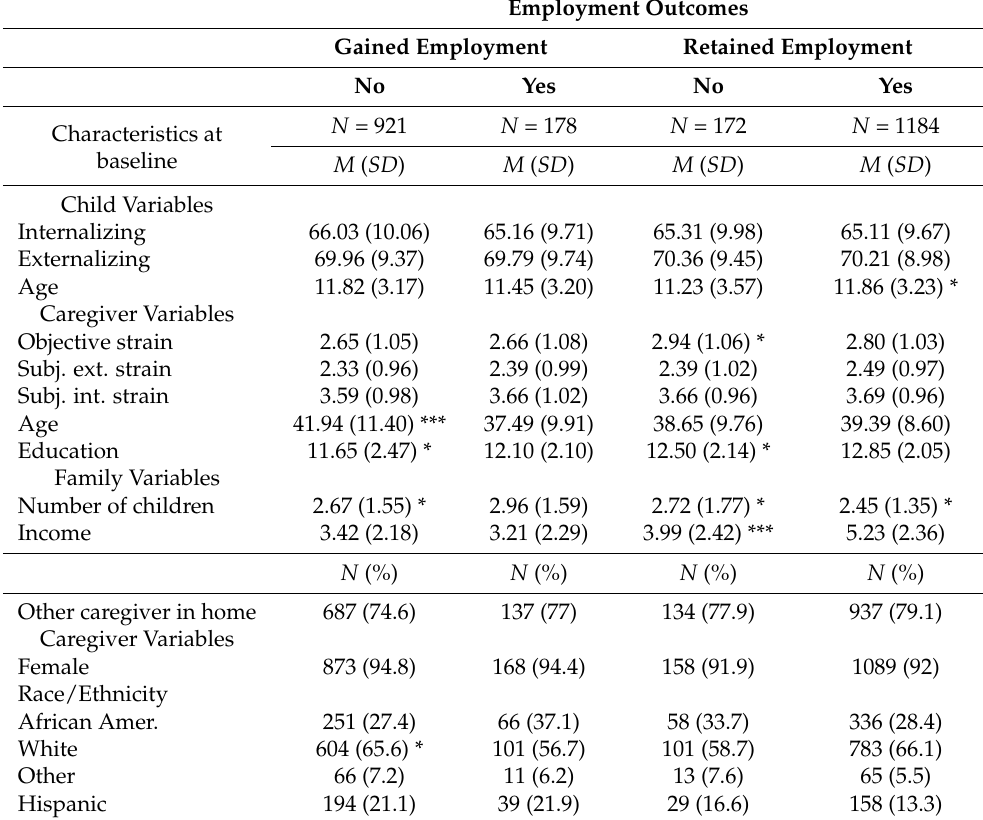
Table 1. Descriptive Statistics by Work Outcome for Caregivers of Children and Youth in Systems of Care.